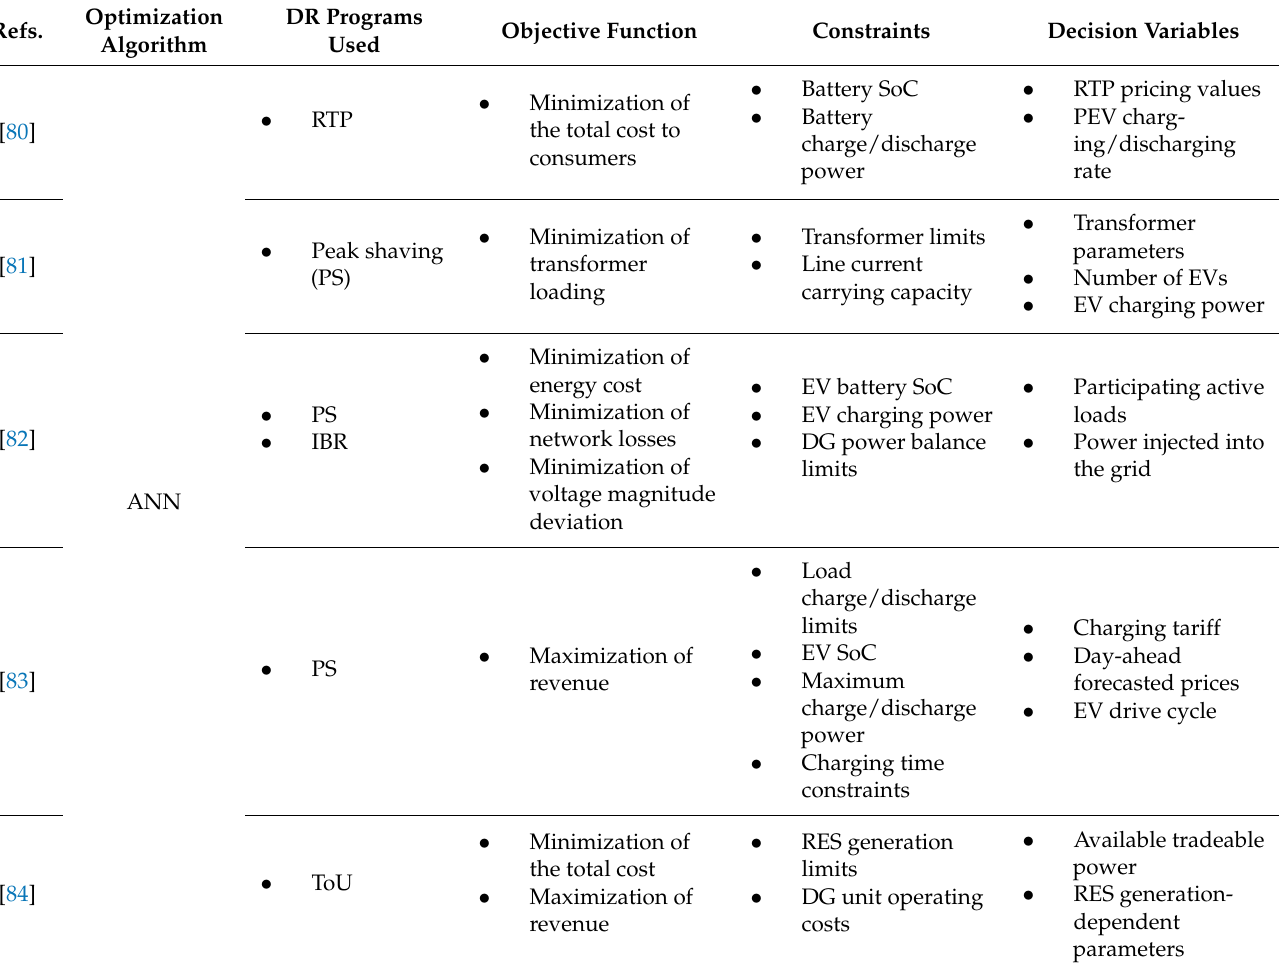
Table 4. The optimization papers surveyed across DGs DSM optimization